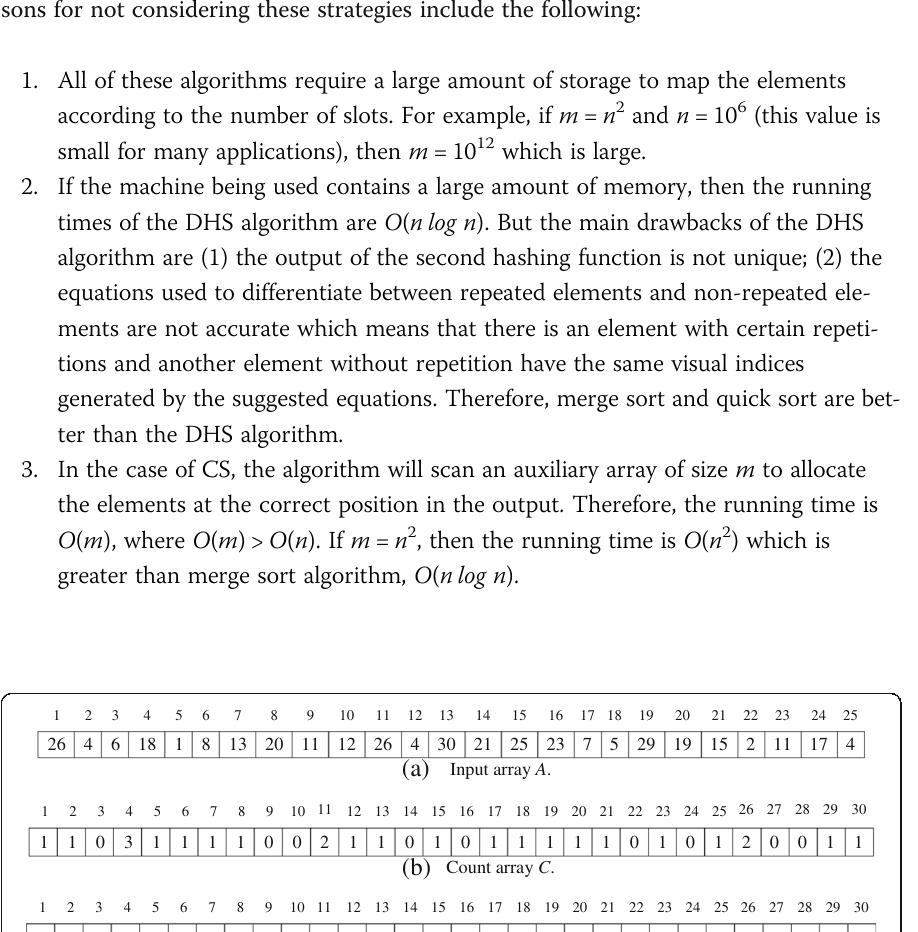
(c) Prefix-sum for C .